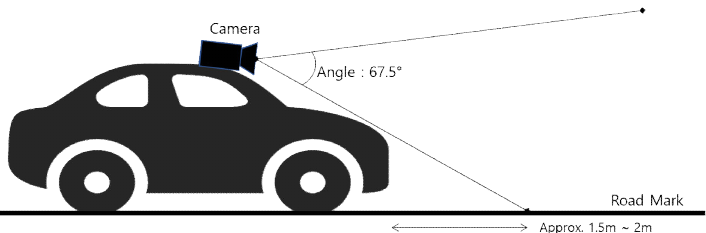
Figure 3. Illustration of the camera setup.